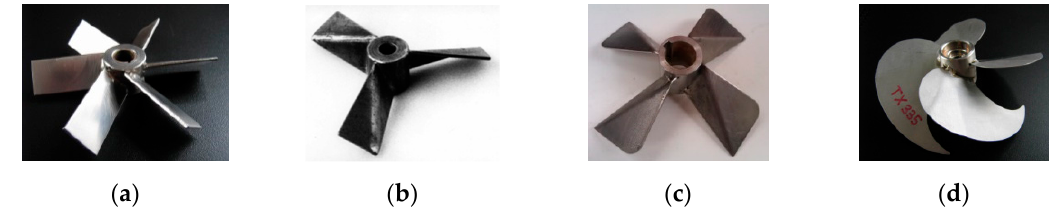
Figure 6. Development stages of axial hydrofoil impellers: ( a ) standard pitched six-blade turbine with pitch angle α = 45°—6SL; ( b ) pitched three-blade turbine with diagonally folded blades—3RLL, ( c ) axial flow impeller with large-area diagonally folded blades—4RLLN [11], ( d ) axial flow hydrofoil impeller TECHMIX TX335.